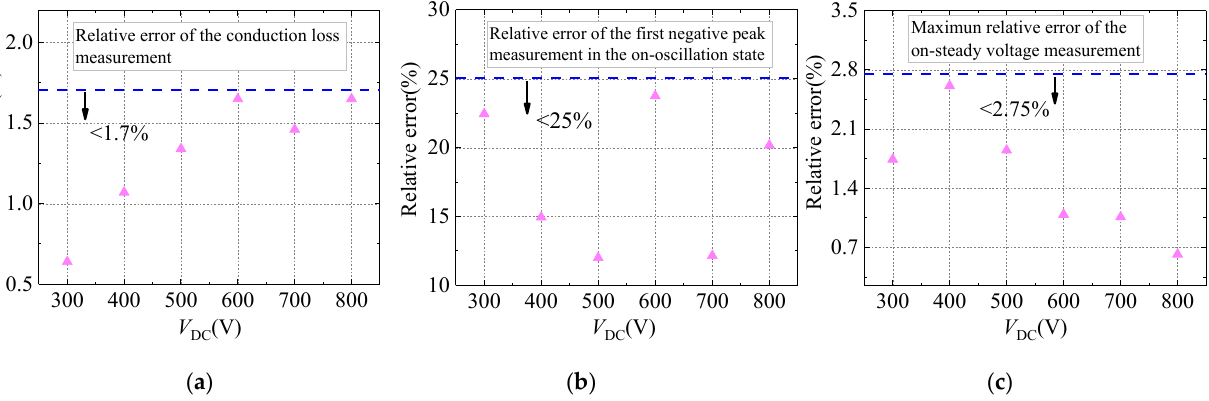
Figure 13. The measurement relative error of improved DVCC. ( a ) Conduction loss; ( b ) on-oscillation state voltage; ( c ) on-steady state voltage.